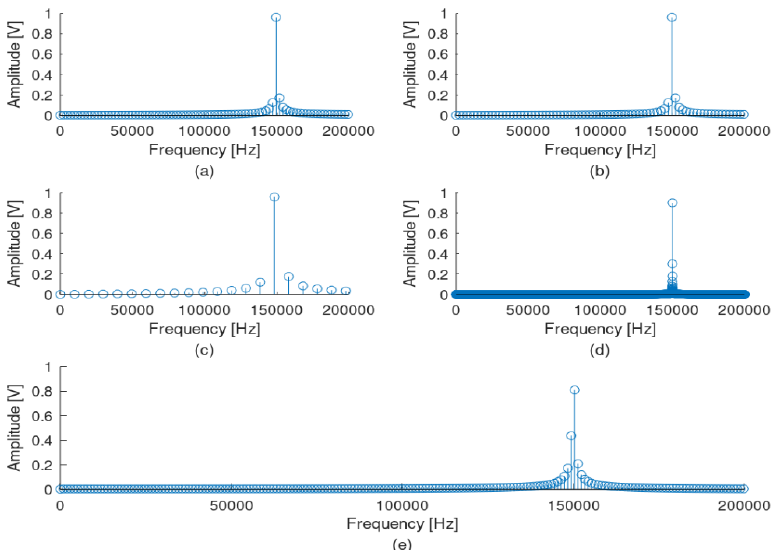
Figure 9. FFT results of the sine signal at 150 kHz in the frequency domain, when different observation windows at the time domain are used. Observation time intervals are ( a ) 0.42 ms, ( b ) 0.4 ms, ( c ) 0.1 ms, ( d ) 1 ms and ( e ) 1.01 ms.